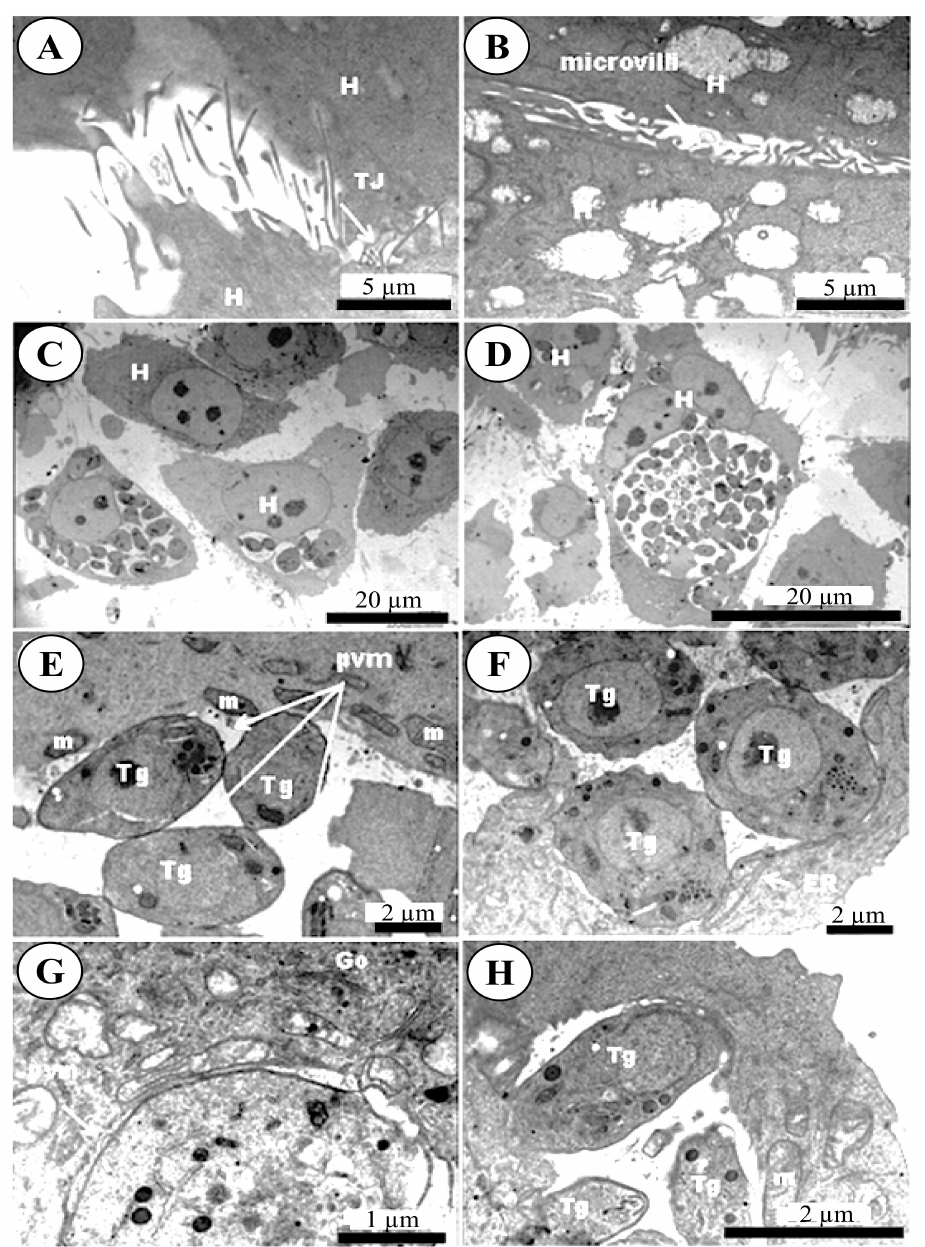
Figure 4. Transmission electron micrographs of BMECs infected by Toxoplasma gondii tachyzoites. ( A , B ) Control host cell (H) showing microvilli and normal intercellular tight junctions (TJ). Infected cells at 24 hpi ( C ) and 48 hpi ( D ) developed larger gaps as the infection advanced. At 24 hpi mitochondria (m) were found condensed around the parasitophorous vacuole membrane (PVM) that enclosed the tachyzoites (Tg) ( E ). The presence of the ER ( F ) and Golgi apparatus (Go) ( G ) around the PVM was also observed. By 48 hpi tachyzoites were getting ready to exit the PV ( H